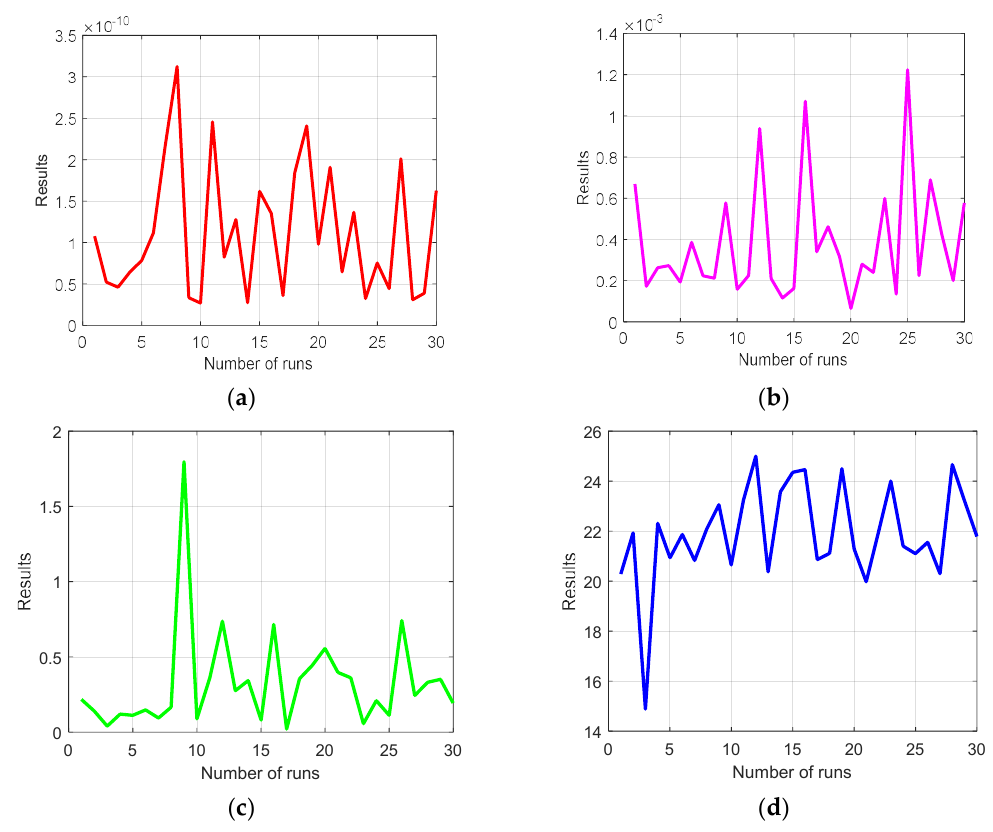
Figure 3. Values of the OF during 30 runs: ( a ) f 1 ; ( b ) f 2 ; ( c ) f 3 ; and ( d ) f 4 .